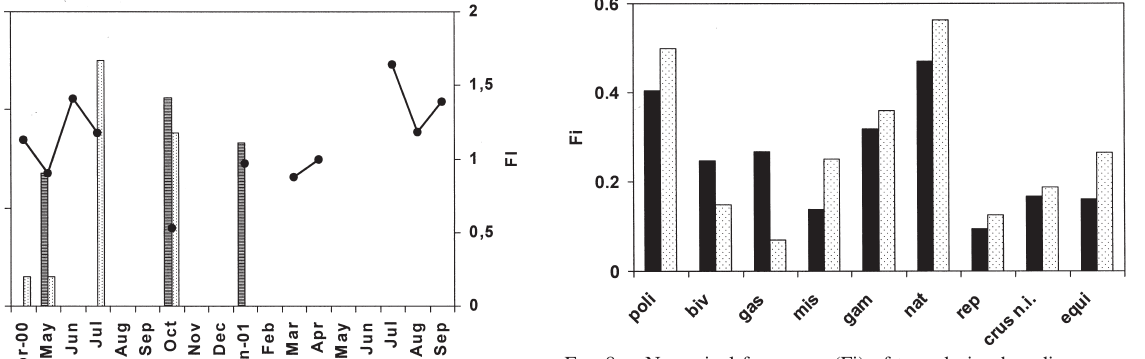
F IG . 8. – Numerical frequency (Fi) of taxa during breeding season for males (black bars) and females (grey bars). Poli: Polychaeta; biv: Bivalvia; gas: Gastropoda; mis: Mysidacea; gam: Gammaridea; nat: Natantia; rep: Reptantia; n.i. crus: non identified Crustacea; equi: